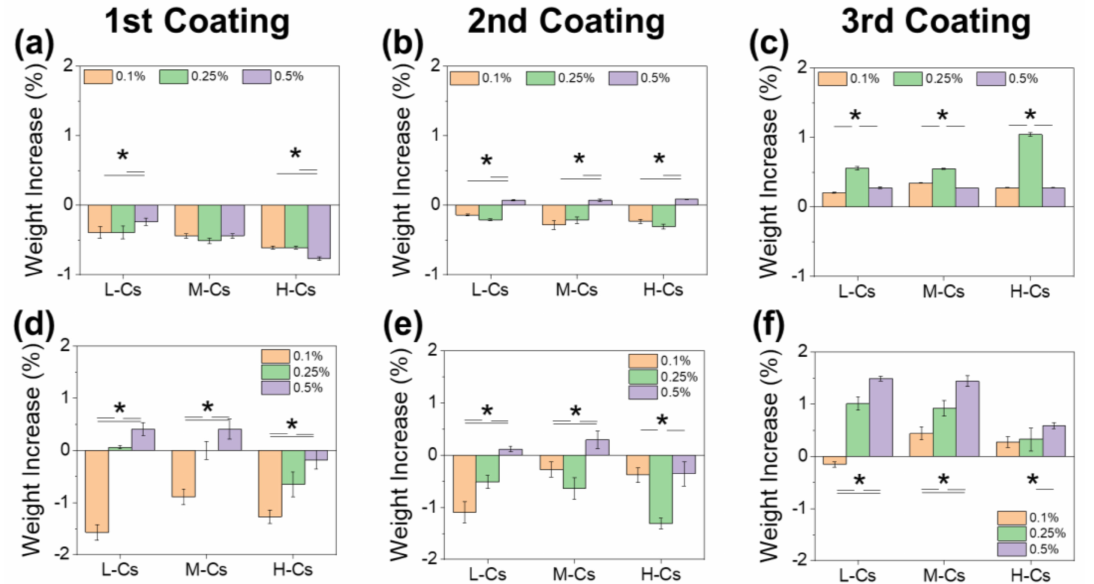
Figure 4. The increase in weight of paper samples after dip coating with chitosan: ( a – c ) Low S% seaweed paper and ( d – f ) High S% seaweed paper. The coating was performed up to three iterations (* p <